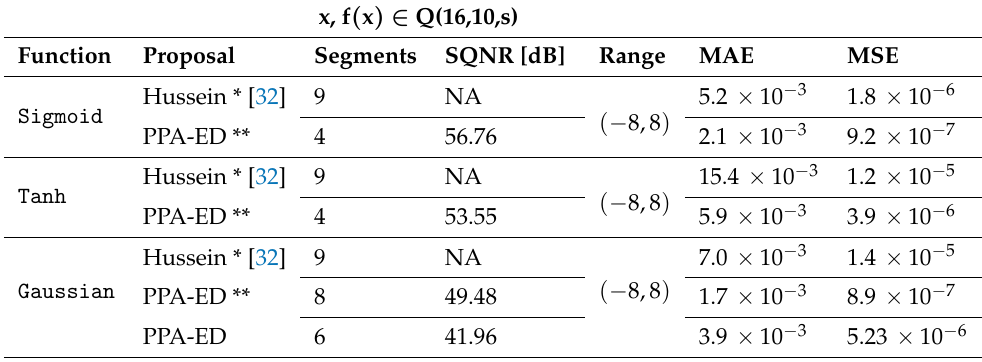
Table 10. Performance comparison for the implemented AFs based on SCPWL and PPA-ED methodologies.